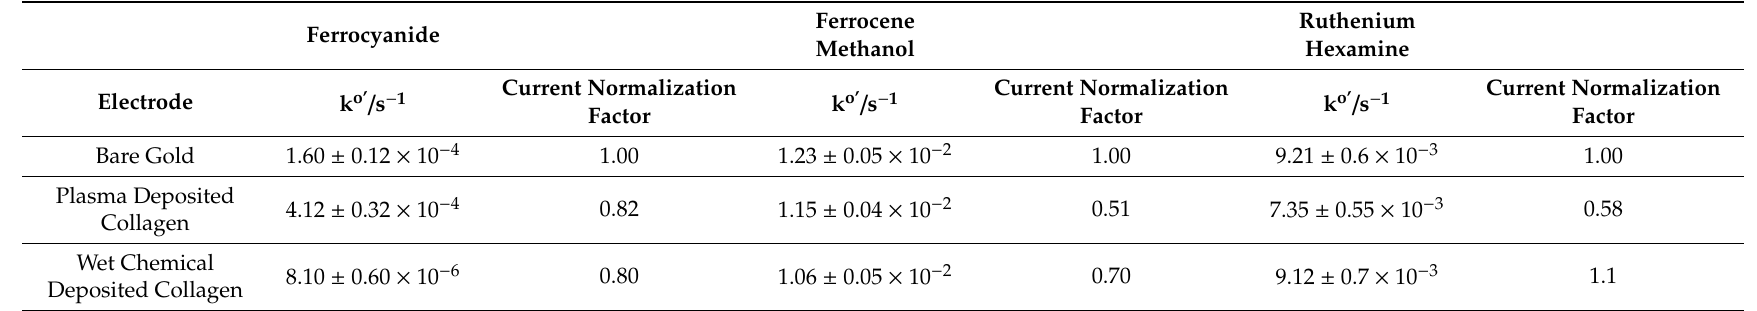
Table 2. Dependence of the standard heterogeneous electron transfer rate constants, k o ’, and apparent fractional area, area normalized to that of the bare electrode, on the method of collagen deposition and the identity of the electroactive probe in